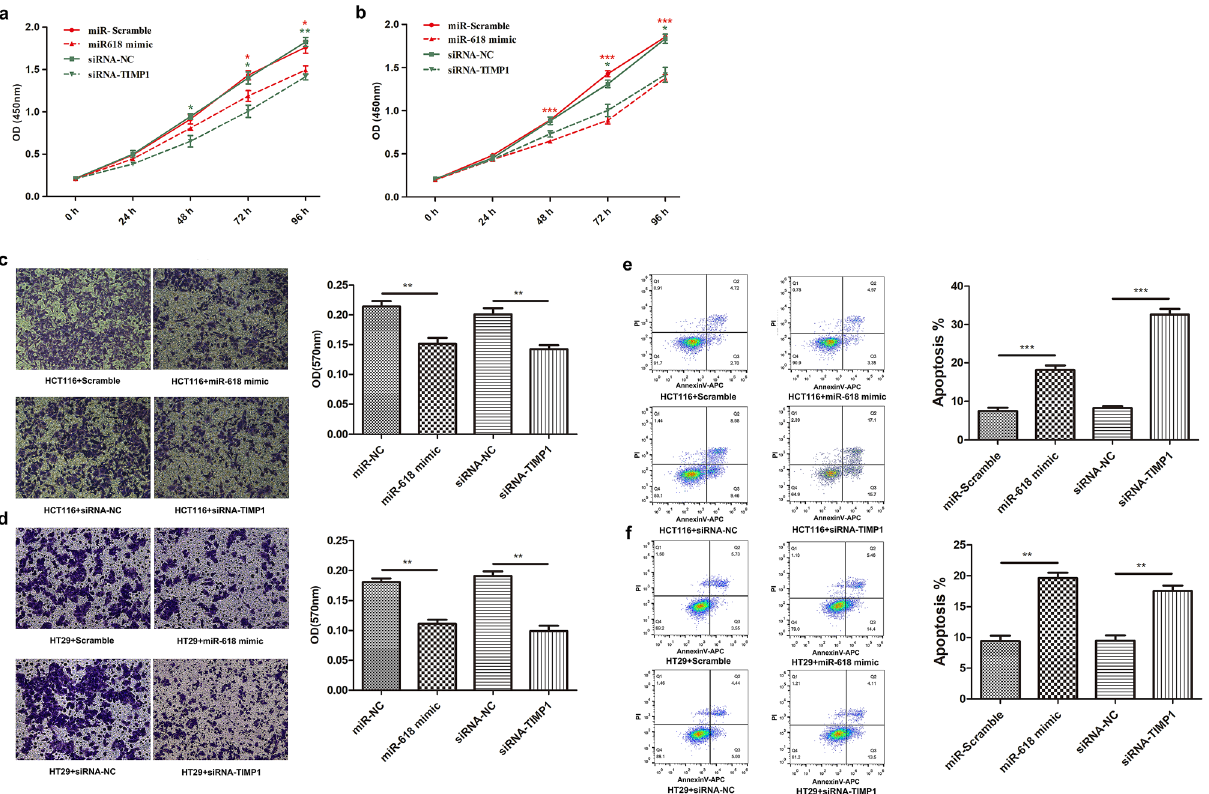
Figure 5. miR-618 and siRNA induced down-regulation of TIMP1 suppresses malignant phenotypes of HCT116 and HT29 cells. Growth curves of HCT116 ( a ) and HT29 ( b ) transfected with miR-618 mimic, miR- Scramble, siRNA-NC or siRNA-TIMP1were shown. The significance of the difference between group miR- Scramble and group miR-618 is indicated in red, as the significance of the difference between group siRNA-NC and siRNA-TIMP1 is indicated in green. * P < 0.05, ** P < 0.01, *** P < 0.001 (t-test). ( c ) Invasion assay of HCT116 cells transfected with miR-618 mimic, miR-Scramble, siRNA-NC or siRNA-TIMP1. ** P < 0.01 (t-test). ( d ) miR-Scramble, siRNA-NC or siRNA-TIMP1. *** P < 0.001 (t-test). ( f ) Flow cytometry analysis of apoptosis of HT29 cells transfected with miR-618 mimic, miR-Scramble, siRNA-NC or siRNA-TIMP1. ** P < 0.01